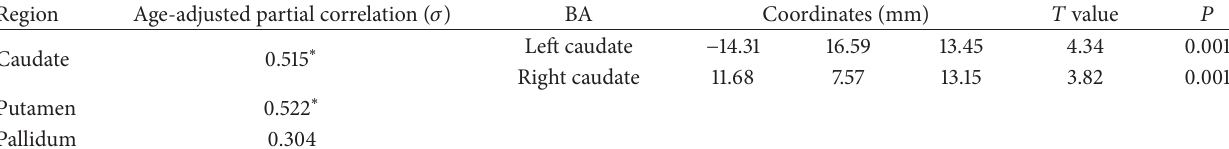
Table 3: Relationship between TIV-adjusted insular volume and basal ganglia substructures.